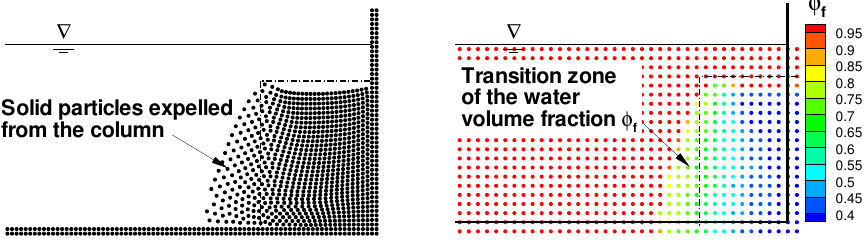
Figure 10. Numerical instability caused by the conventional SPH approximation of the pore water pressure gradient, i.e., Equation